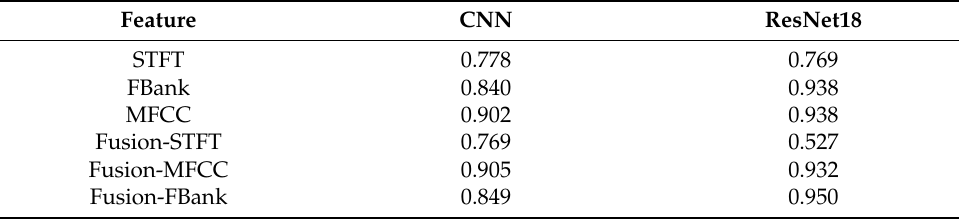
Table 3. The accuracy of different feature extraction methods.